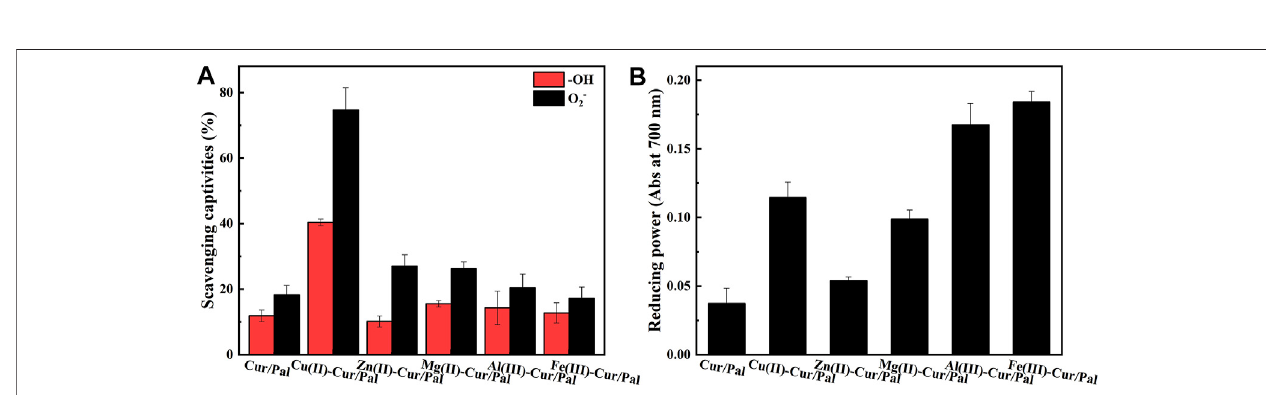
FIGURE 8 | Antioxidant activity (A) and reducing power (B) of Cur/Pal and metal ions-Cur/Pal hybrid materials.